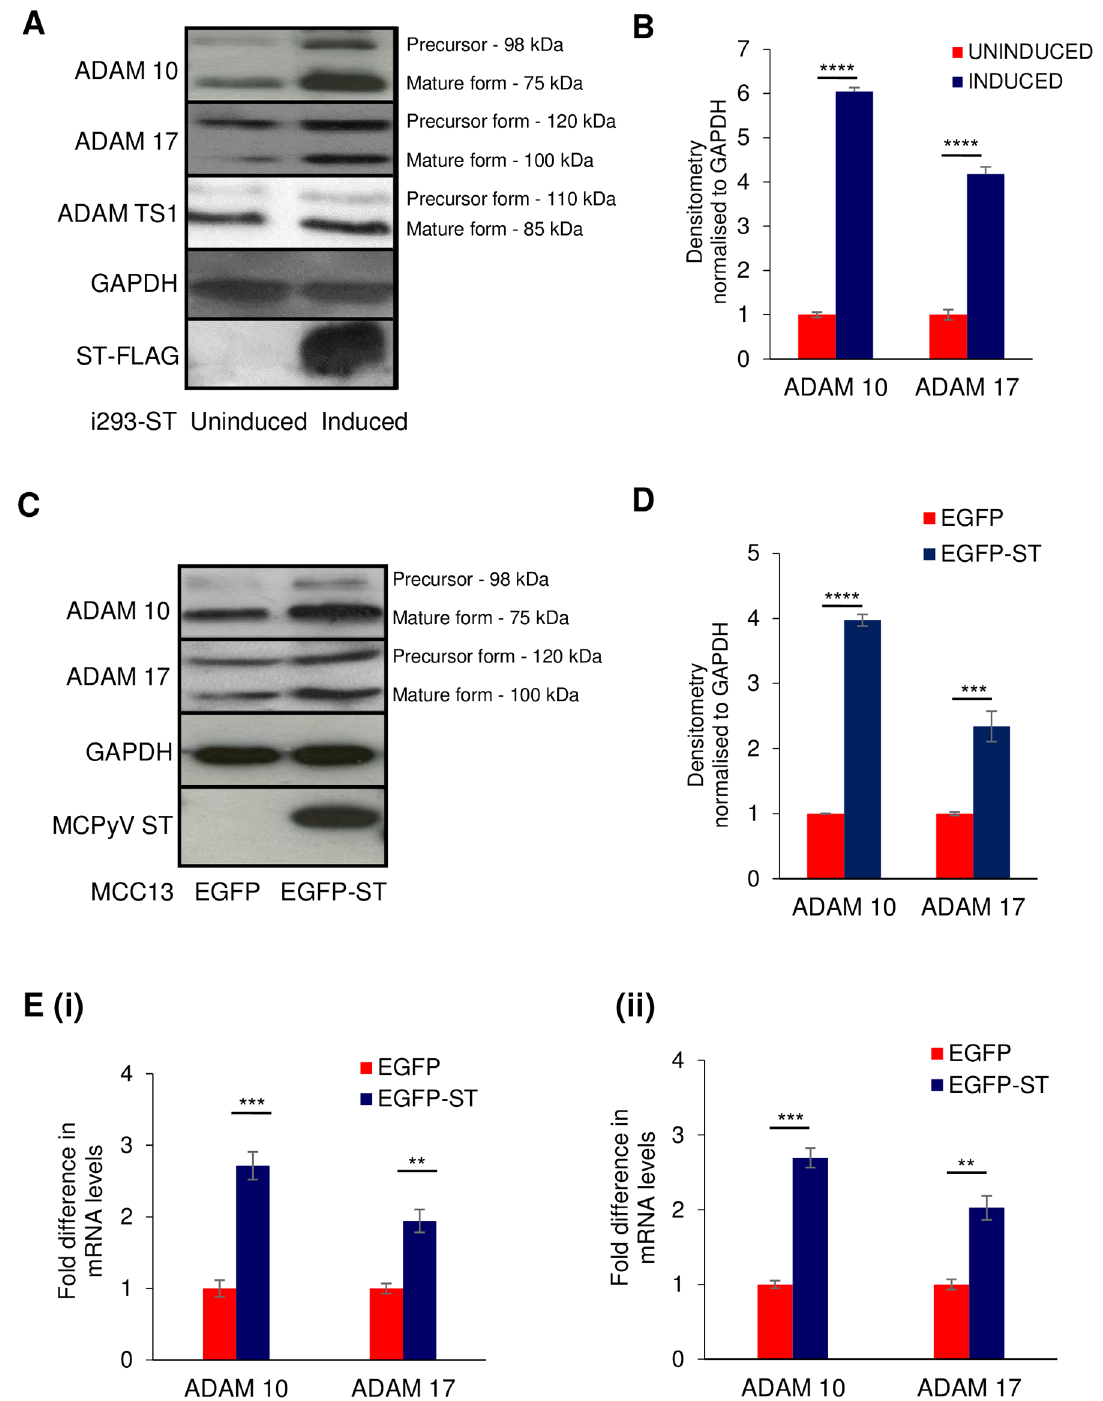
Fig 2. MCPyV ST expression increases the levels of ADAM proteins. (A) i293-ST cells remained uninduced or were incubated for 48 hours in the presence of doxycycline hyclate or (C) MCC13 cells were transfected with 1μg of pEGFP or pEGFP-ST for 12 hours. Cell lysates were then probed with ADAM 10-, ADAM 17- and ADAM TS1-specific antibodies. GAPDH was used as a measure of equal loading, the 2T2 hybridoma was used to confirm MCPyV ST expression. (B and D) Densitometry quantification of immunoblots was carried out using the Image J software and is shown as a percentage relative to the loading control, GAPDH. Data analysed using three replicates per experiment, n = 3 and statistical analysis using a two-tailed t-test with unequal variance, (cid:3)(cid:3)(cid:3) = p < 0.001, (cid:3)(cid:3)(cid:3)(cid:3) = p < 0.0001. (E) Total RNA was extracted from EGFP or EGFP-ST transfected (i) HEK 293 and (ii) MCC13 cells and relative transcript levels were